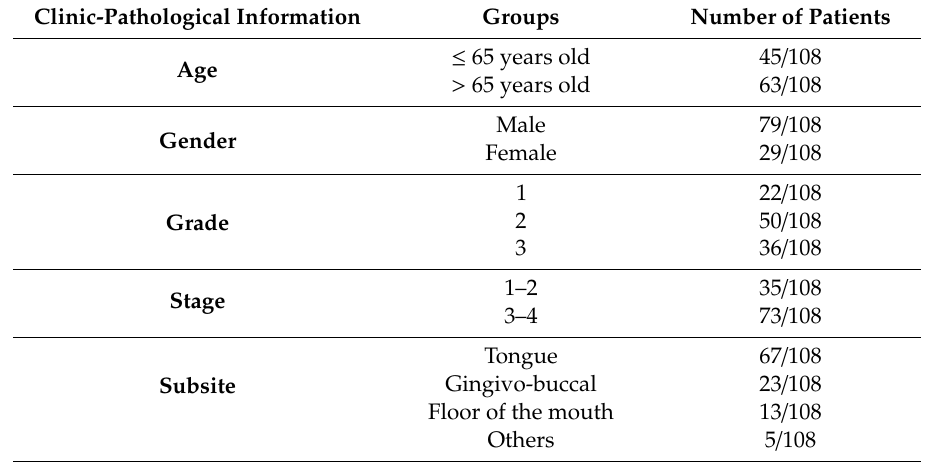
Table 3. Clinical-pathological characteristics of patients included in the immunoistochemical analysis.